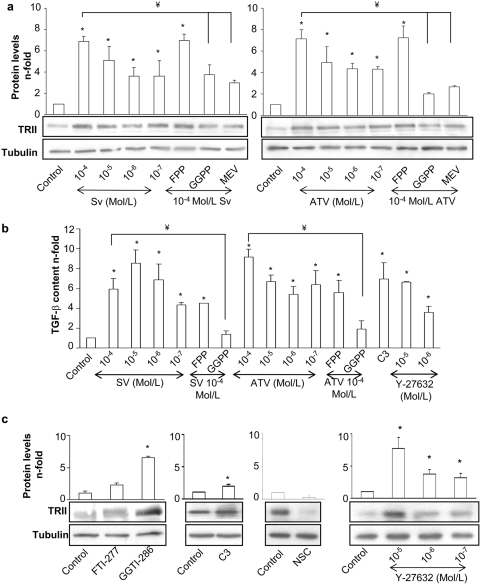
Statins upregulates TGF-β receptor type II (TRII) (a) and TGF-β synthesis in VSMCs (b).Serum starved VSMCs were incubated for 48h with several concentrations (10−4 to 10−7 mol/L) of Simvastatin (SV) or Atorvastatin (ATV). Some cells were pretreated for 1h with 5 µg/mL FPP or GGPP or 10−4 mol/L mevalonate (MEV) before statin treatment. RhoA/ROCK inhibition increases TRII in VSMCs (c) and TGF-β synthesis in VSMCs (b). c. Serum starved VSMCs were incubated for 48h with FTI-277 or GGTI-286(10-5 Mol/L), C3 exoenzyme (10 µg/mL), NSC-23766 (50mMol/L) or Y-27632 (10-5 to 10-7 mol/L). Figures a and c show in the lower panel representative western blot of TRII expression and in the upper panel relative TRII protein levels expressed as mean±SEM of 4 experiments. Figure b shows TGF-β content measured in conditioned media by ELISA. Data are expressed as mean±SEM of n-fold of increase vs unstimulated cells from 4 experiments. *p<0.05 vs. control. ¥ p<0.05 vs. SV 10-4 Mol/L.